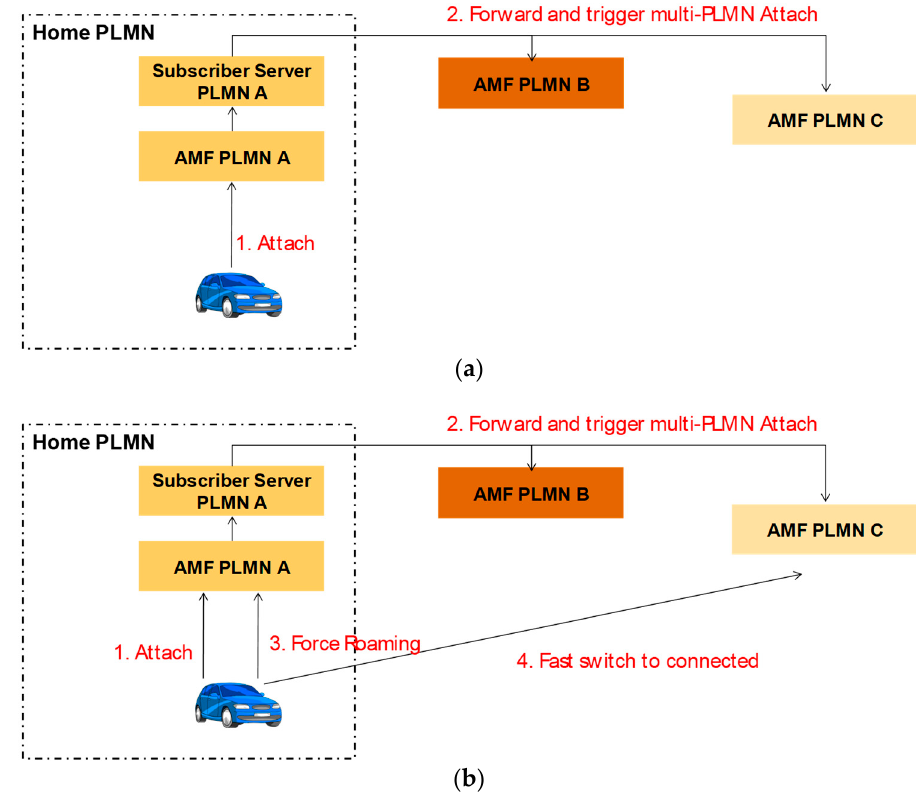
Figure 11. ( a ) Pre-attach to operators and ( b ) force roaming procedures.